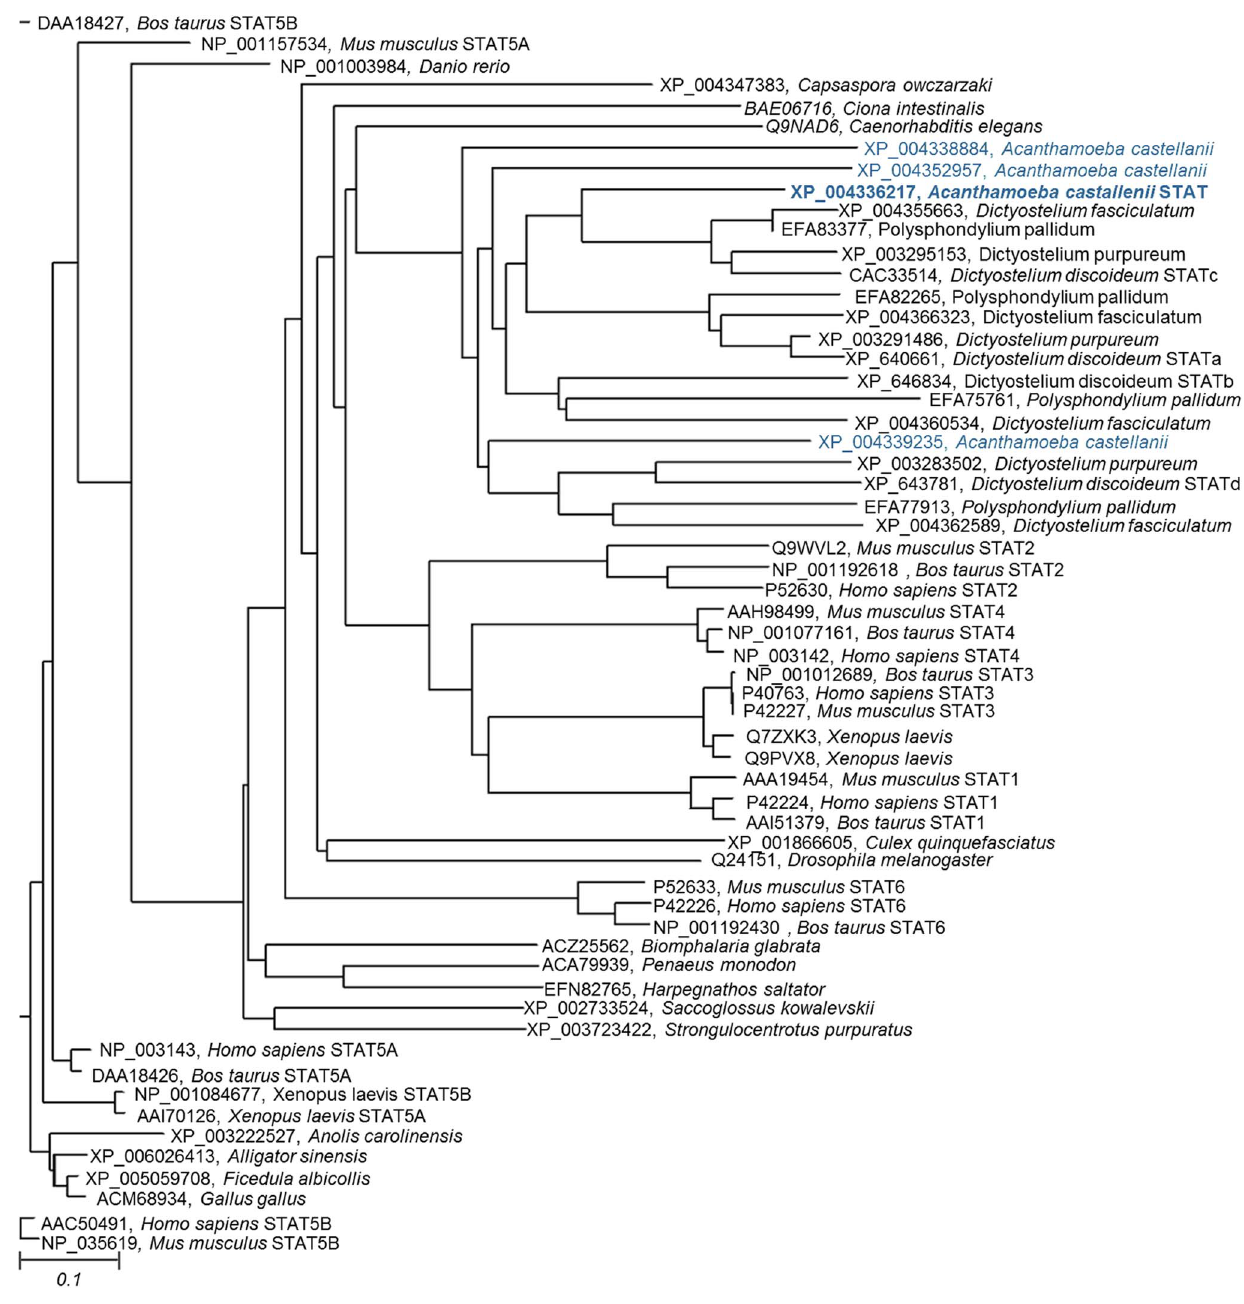
Figure 4. Molecular phylogenetic analysis by Maximum Likelihood method of 59 STAT proteins from selected Ophistokonta and Amoebozoa. The results were obtained using Phylip.